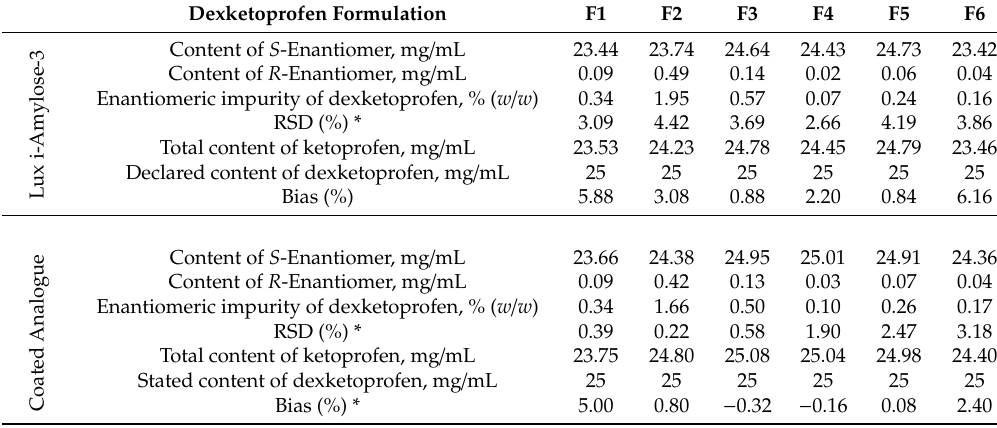
Table 5. Content of ketoprofen enantiomers in marketed dexketoprofen